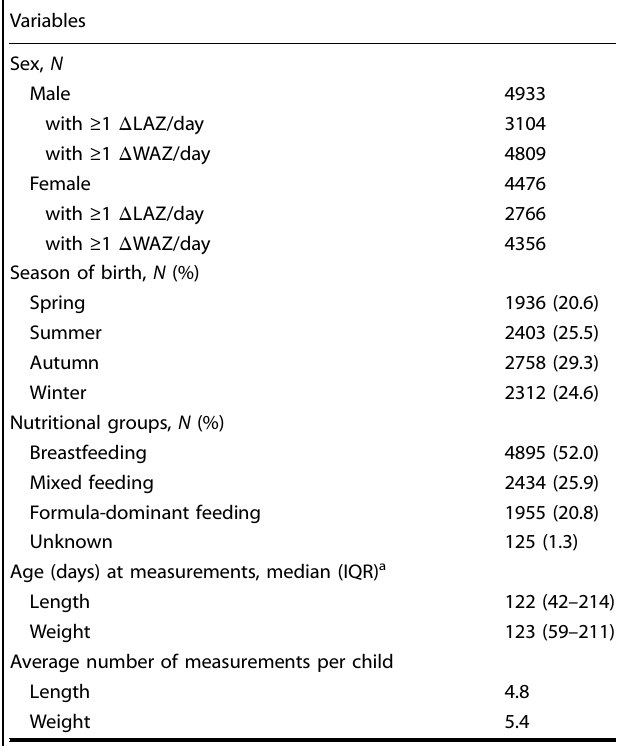
Table 1. Characteristics of the